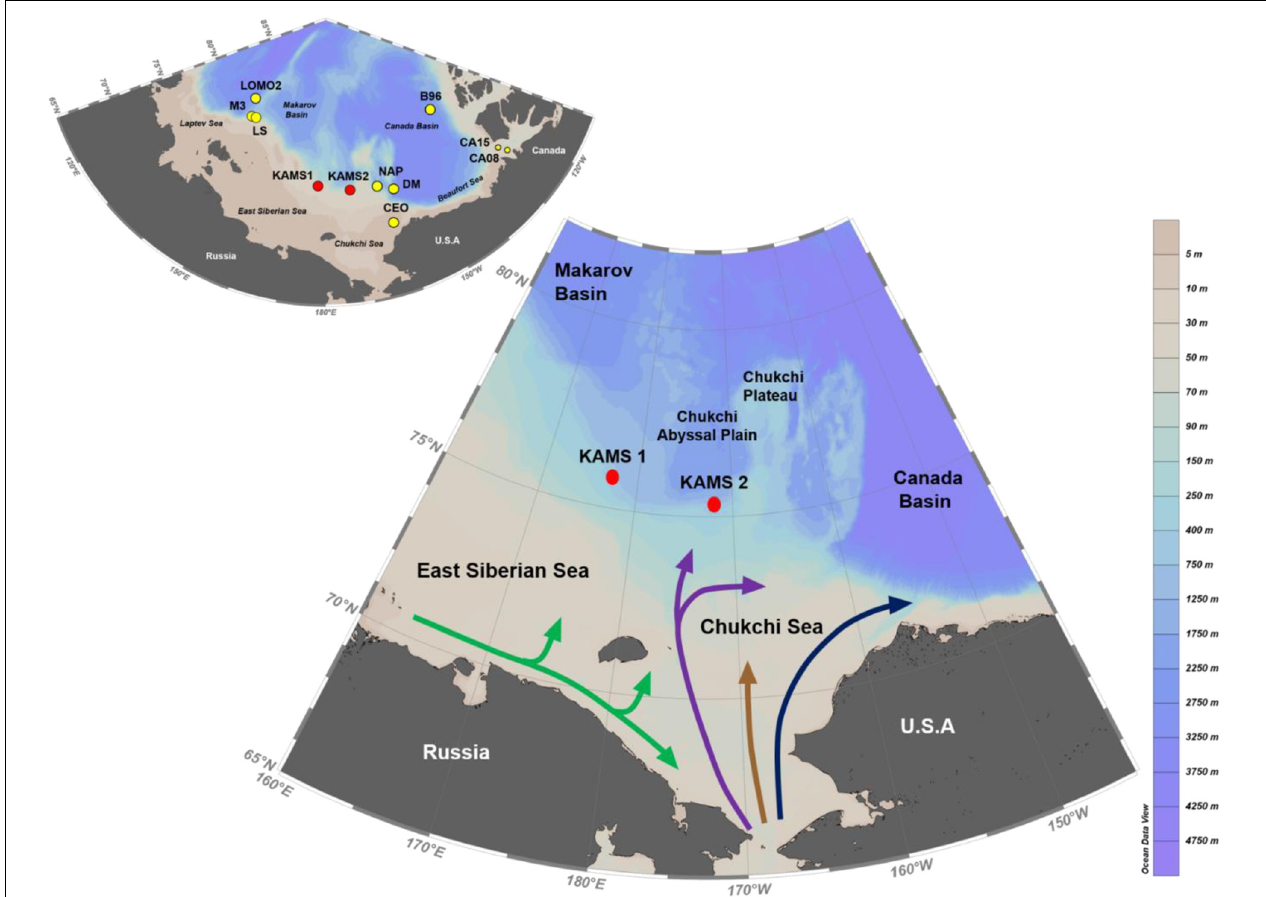
FIGURE 1 | Map showing sediment-trap mooring sites (KAMS 1 and 2) and surface ocean circulation patterns. The blue line indicates Alaska Coastal water, the brown line indicates Bering Sea Shelf water, the purple line indicates Anadyr Water, and the green line indicates the Siberian Coastal Current (after Bai et al., 2019). The inset figure indicates the sediment trap mooring sites presented in Table 2